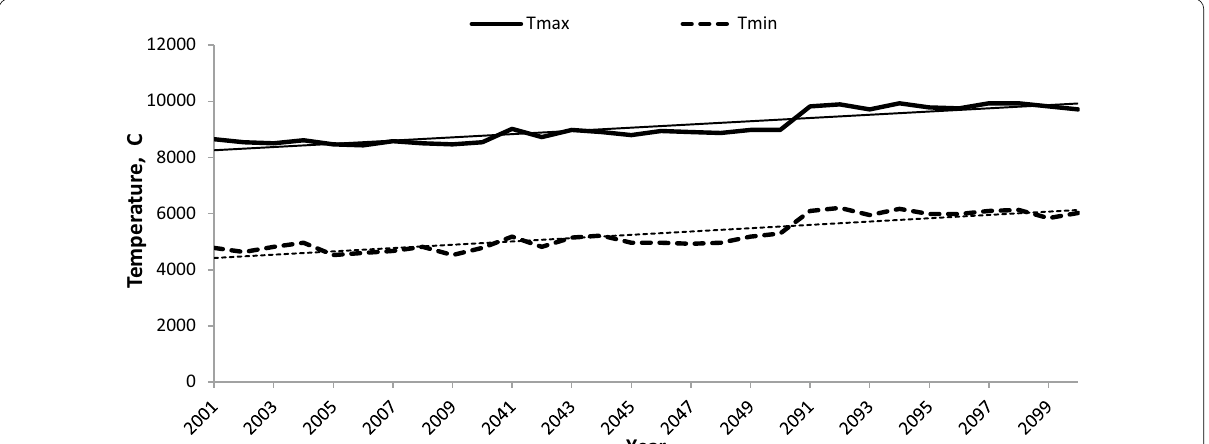
Fig. 6 Projected maximum and minimum annual temperature trends